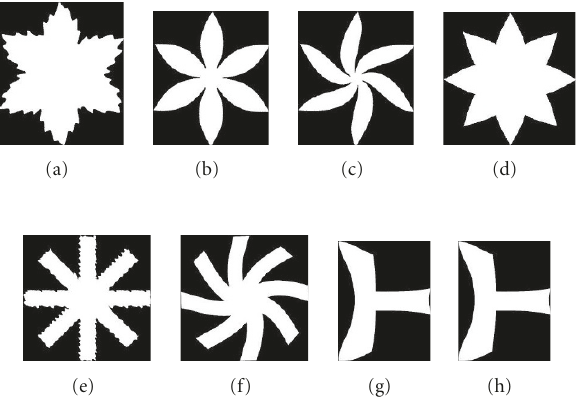
Figure 5: The database of device